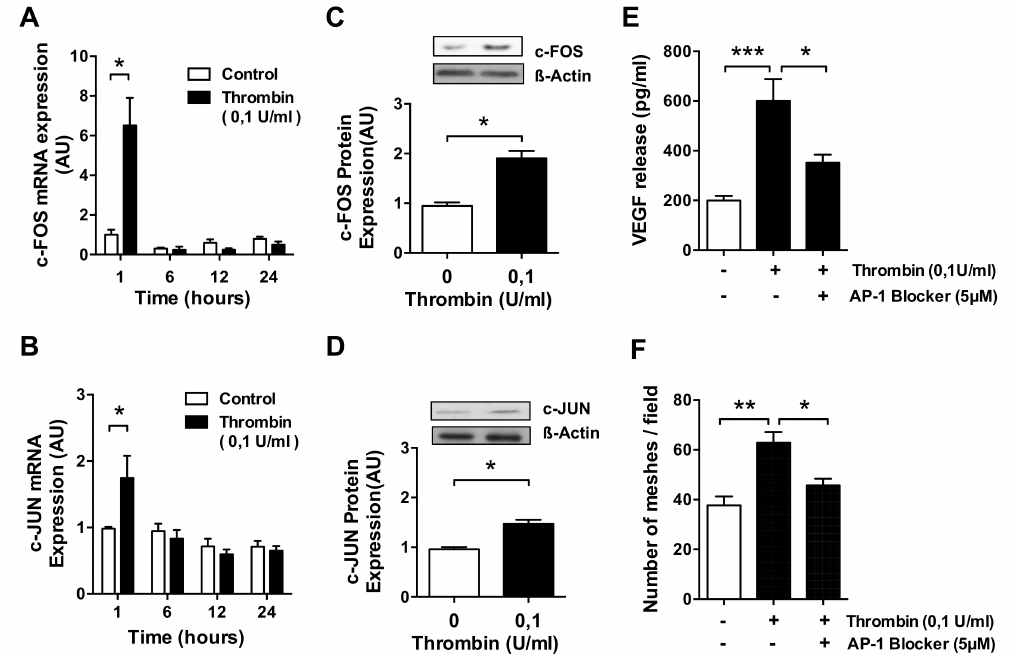
Figure 4. Engagement of AP-1/c-FOS/c-JUN signaling in thrombin-stimulated microvascular ECs. ( A – C ) HMECs were treated with thrombin (0.1 U/mL) for the times indicated and assessed for: ( A , B ) c-FOS and c-JUN mRNA level ( n = 4); ( C , D ) c-FOS and c-JUN protein upregulation after 3 h of stimulation ( n = 4); ( E , F ) HMECs were preincubated for 1 h with or without the AP-1 inhibitor SR-11302 (5 µ M) and then stimulated with thrombin (0.1 U/mL) for 24 h, followed by the measurement of ( E ) VEGF protein release ( n = 7–8) and ( F ) the number of endothelial network meshes formed per field ( n = 6). ANOVA mean +/ − SEM with * p < 0.05, ** p < 0.01, and *** p <